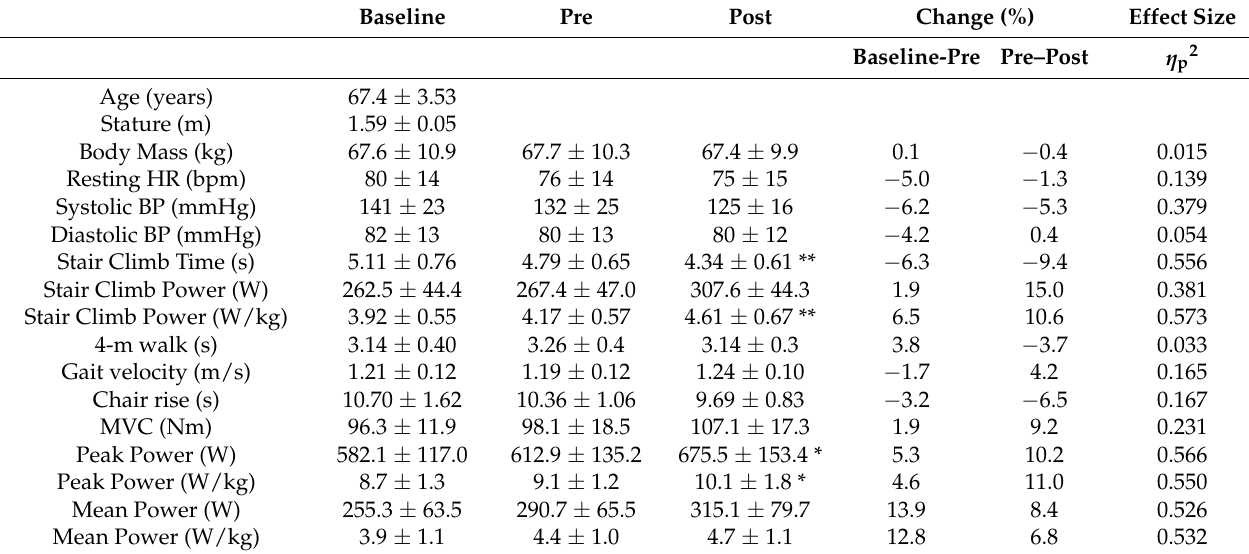
Table 2. Main outcome variables at baseline, pre-intervention (pre) and post-intervention